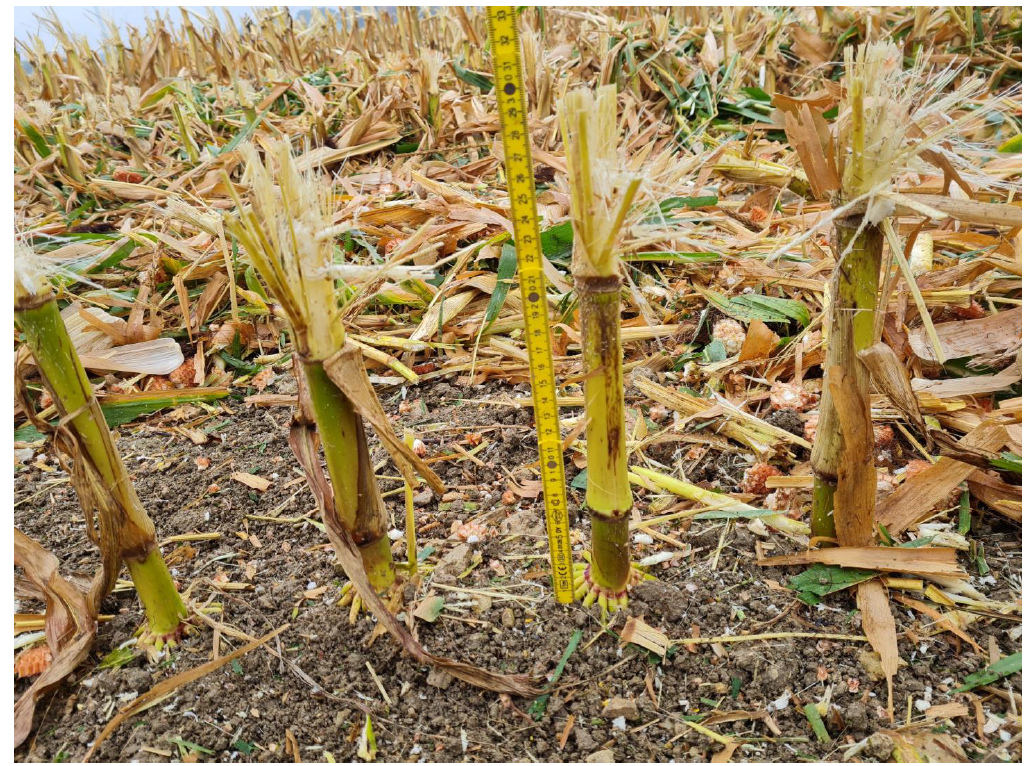
Figure A5. Corn stubble processed by the corn header with disengaged horizontal choppers (cutting height level 1). Table A1. Coefficients of the linear mixed effects regression model for the dependent variable